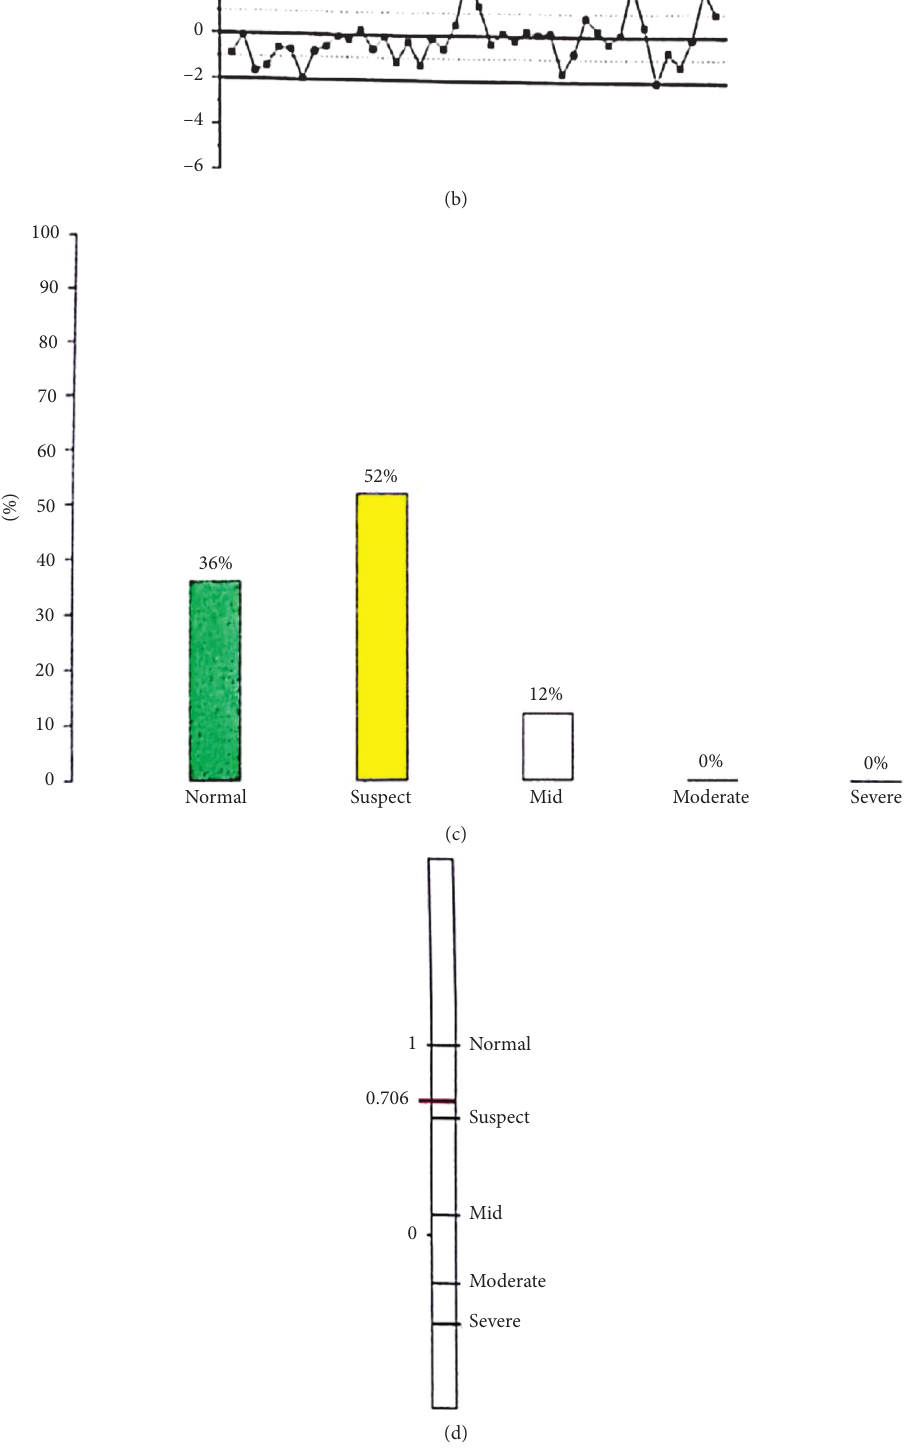
Figure 5: ORA signal of the left eye of a patient in group 2 (keratoconus suspect). (a) Waveform and measurement values. (b) Waveform parameters deviation from mean. (c) Keratoconus match probabilities. (d) Keratoconus match